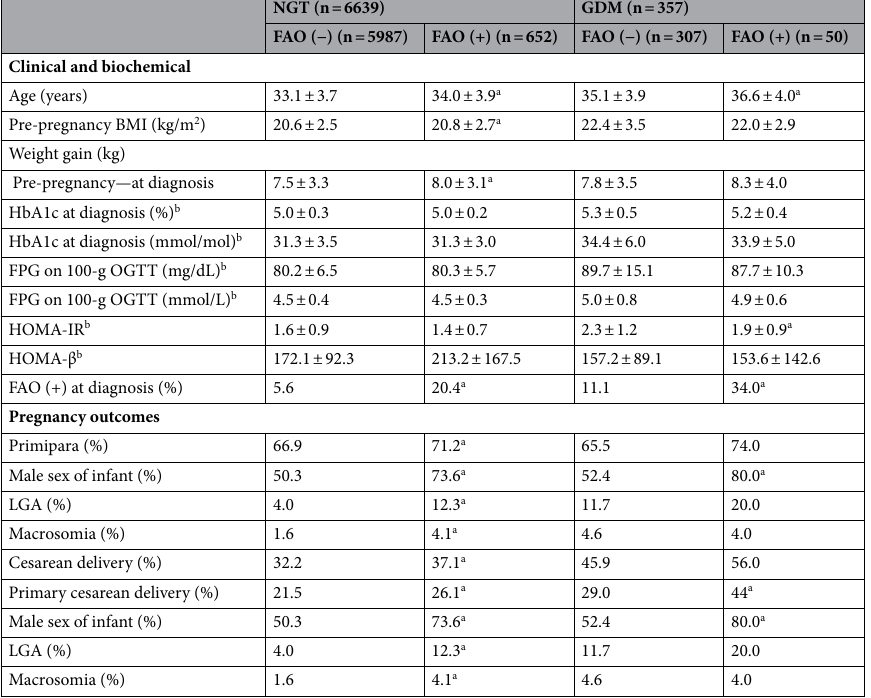
Table 4. Clinical and biochemical characteristics and pregnancy outcomes by presence or absence of FAO at 20–24 GW in the subjects subsequently diagnosed with NGT and GDM. FAO fetal abdominal obesity, GW gestational weeks, NGT normal glucose tolerance, GDM gestational diabetes mellitus, BMI body mass index, HbA1c glycosylated hemoglobin, FPG fasting plasma glucose, OGTT oral glucose tolerance test, HOMA-IR homeostatic model assessment for insulin resistance, HOMA-β homeostatic model assessment for insulin secretion, LGA large for gestational age. a p < 0.05 compared to FAO (–), b Column Ns for the variable are different from the Ns presented in the table.